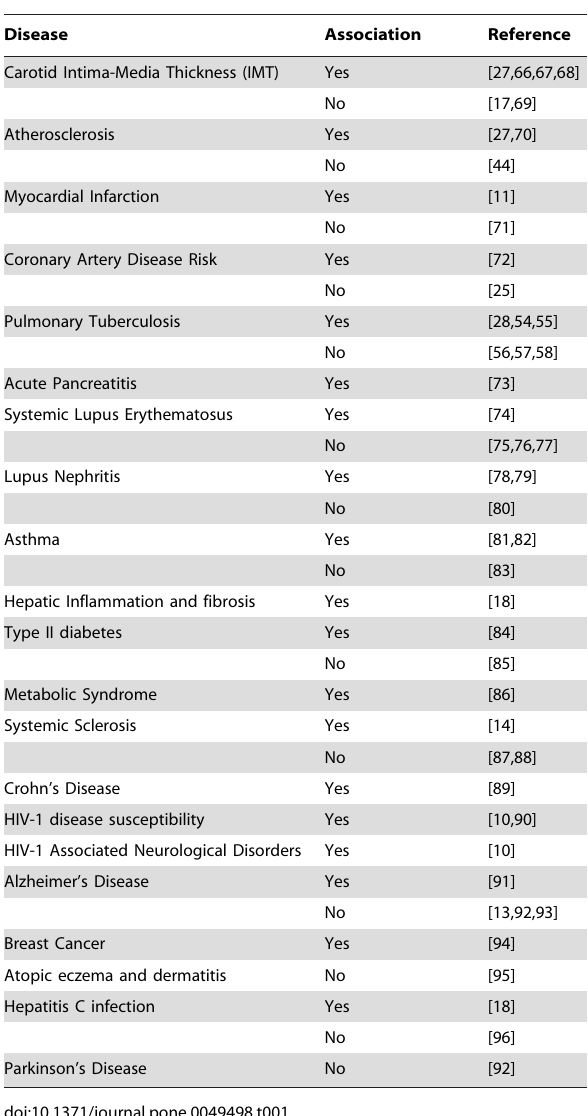
Table 1. Disease associations of the CCL2 rs1024611